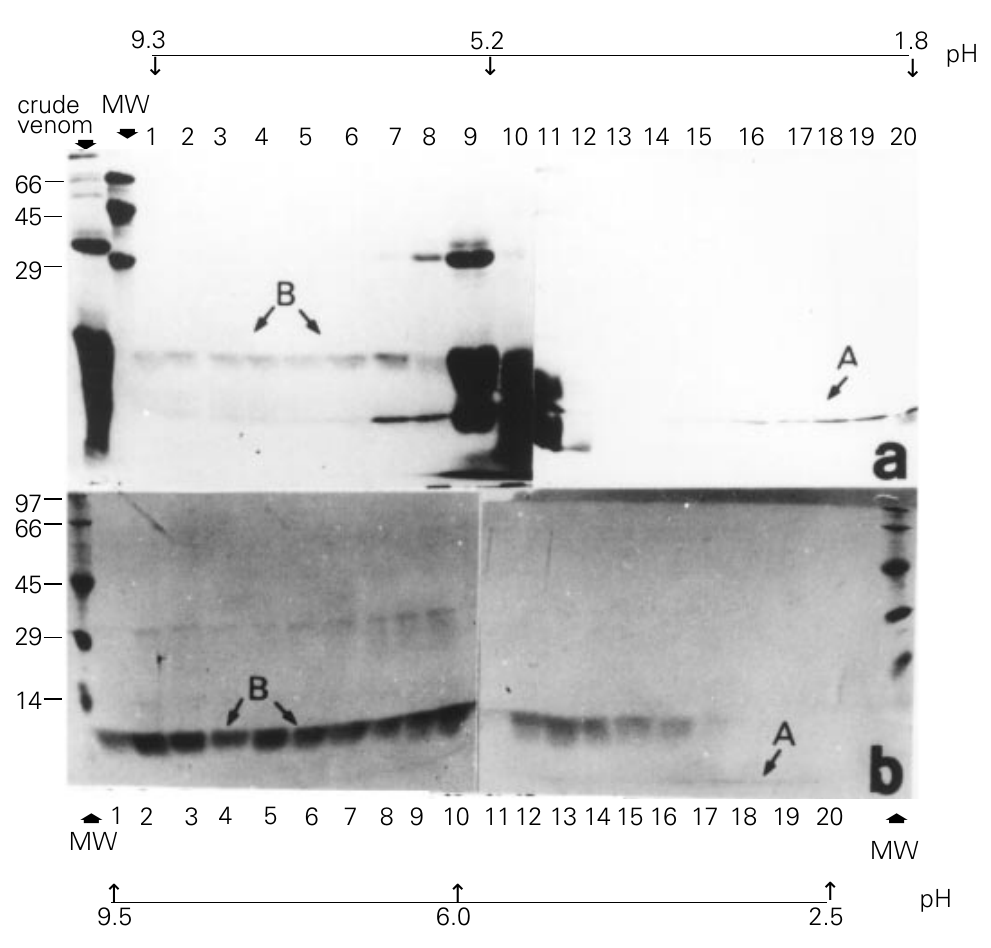
Figure 1 - SDS-polyacrylamide (15%) gel electrophoresis of the Crotalus durissus terrifi- cus venom proteins fraction- ated in a Rotofor cell (frac- tions 1 to 20) without (panel a) and with (panel b) 1 M urea. In Figure 1a, 16-26 (cid:181)g of pro- tein was applied to each lane except intact venom to which 25 (cid:181)g was applied. In Figure 1b, 20-28 (cid:181)g of protein was applied to each lane. The gels were stained with Coomassie blue. On the left side of the figures the Mr values of the standard proteins [phospho- rylase B (97,400), bovine se- rum albumin (66,000), ovalbu- min (45,000), carbonic anhy- drase (29,000) and lysozyme (14,500)] are shown and the pH values determined after isoelectrofocusing are indi- cated above and below the figure. In the top panel, frac- tions 1 to 6 were combined to provide crotactine and frac- tions 15 to 19 contained cro- tapotin. A, The acidic protein crotapotin; B, the basic pro- tein crotactine. (cid:231)